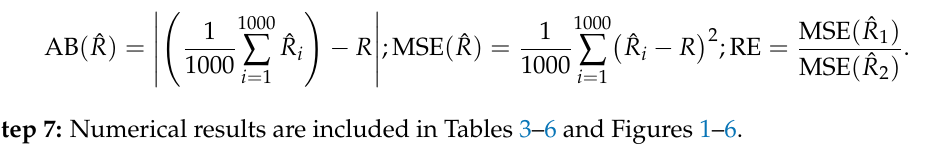
Table 3. ML estimates, AB, MSE, and RE of ˆ R 1 and ˆ R 2 for OSS for s = 5